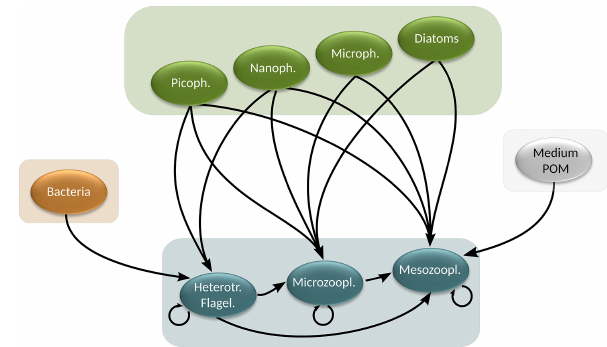
Figure 3. Pelagic predators and their